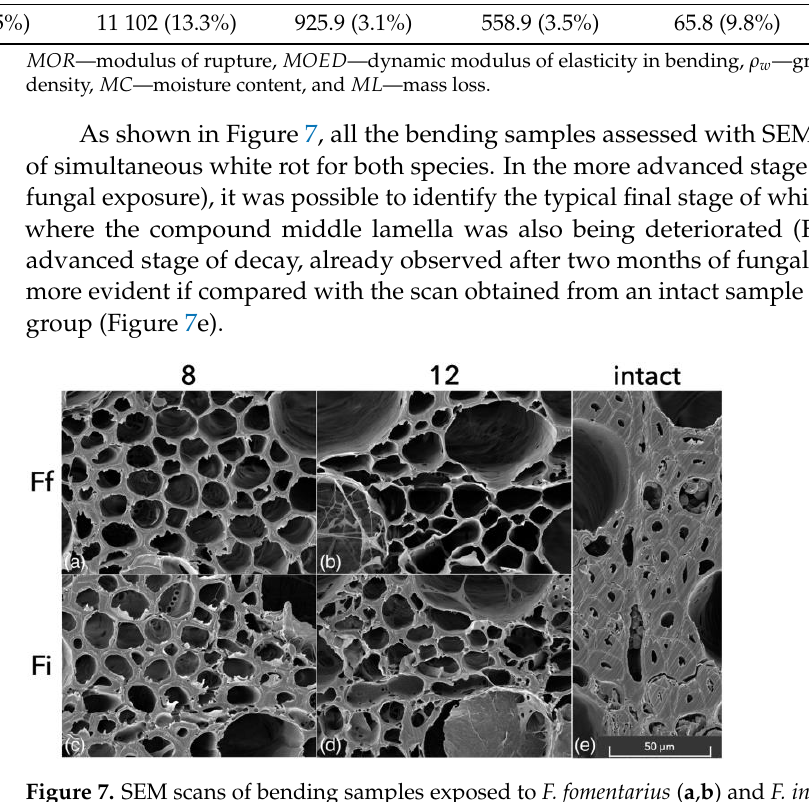
Figure 6. Linear relationship between 𝑀𝑂𝑅 and 𝑀𝑂𝐸𝐷 for bending specimens exposed to F. fo- mentarius ( a ) and F. inzengae ( b ) cultures and a closer representation without data from intact sam- ples ( c , d ).